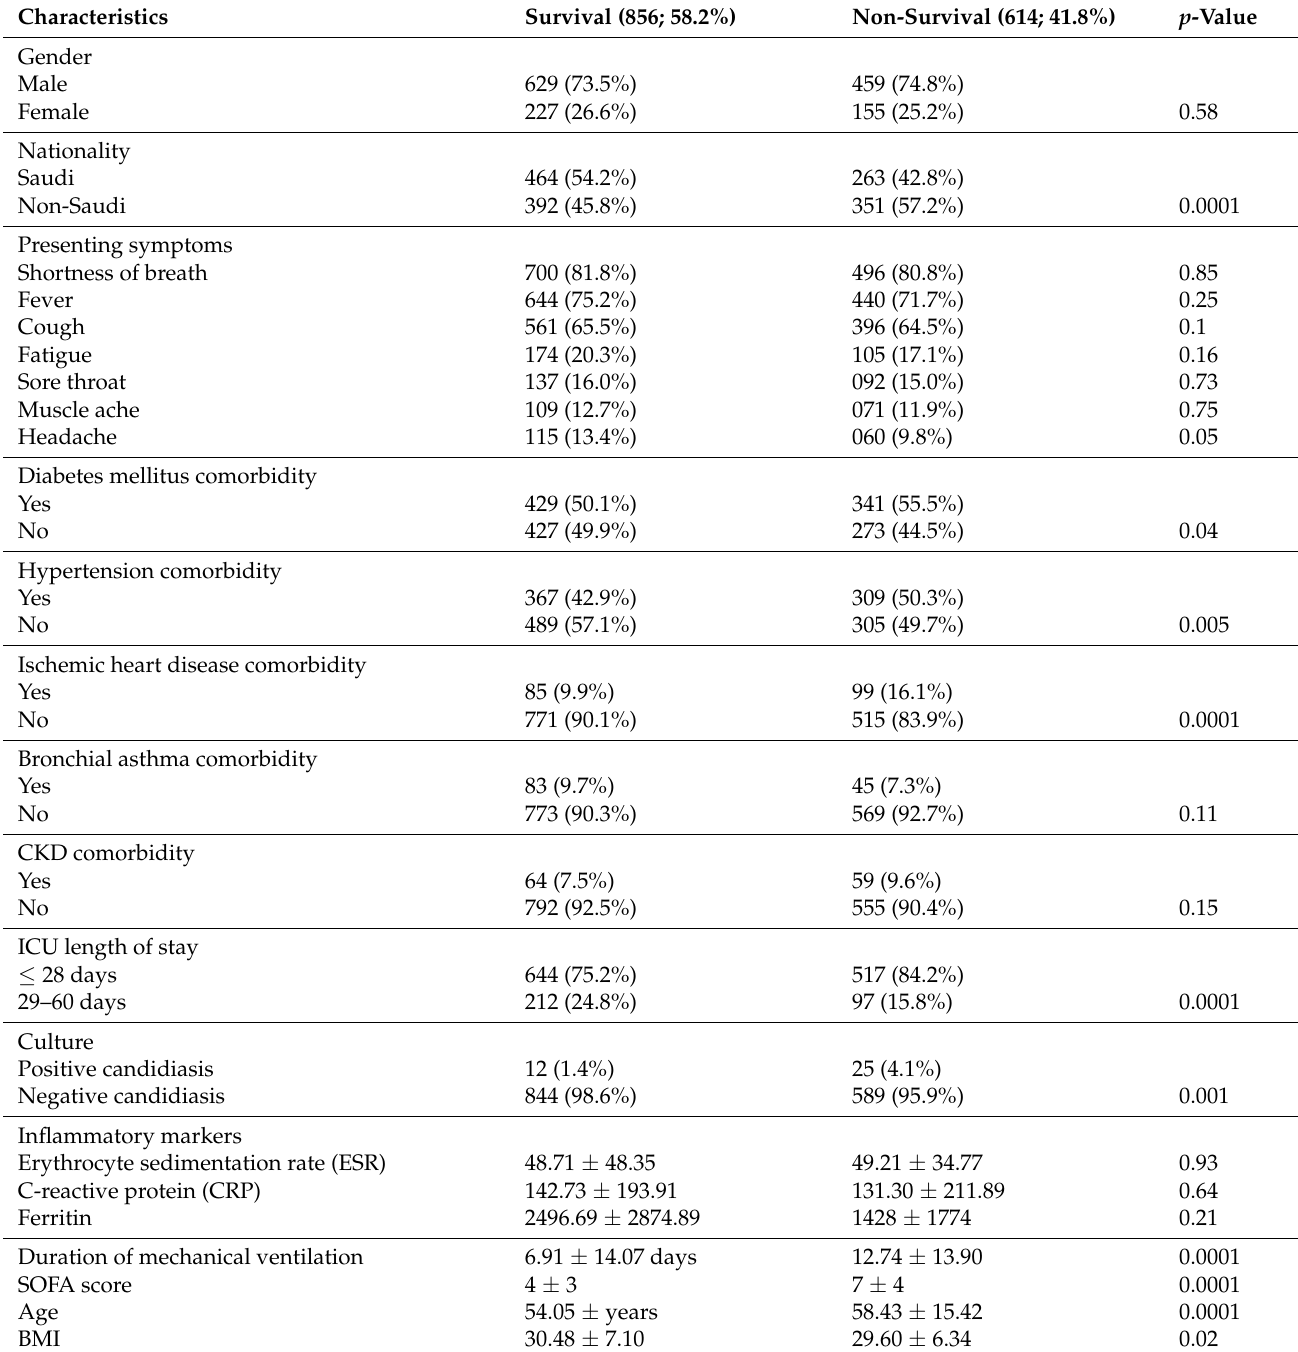
Table 1. Baseline characteristics ( n =